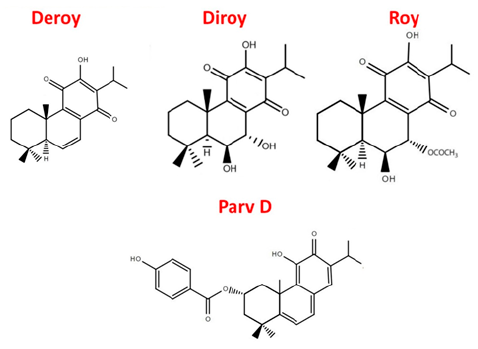
Figure 1. Abietane diterpenes isolated from P. madagacariensis and P. ecklonii .